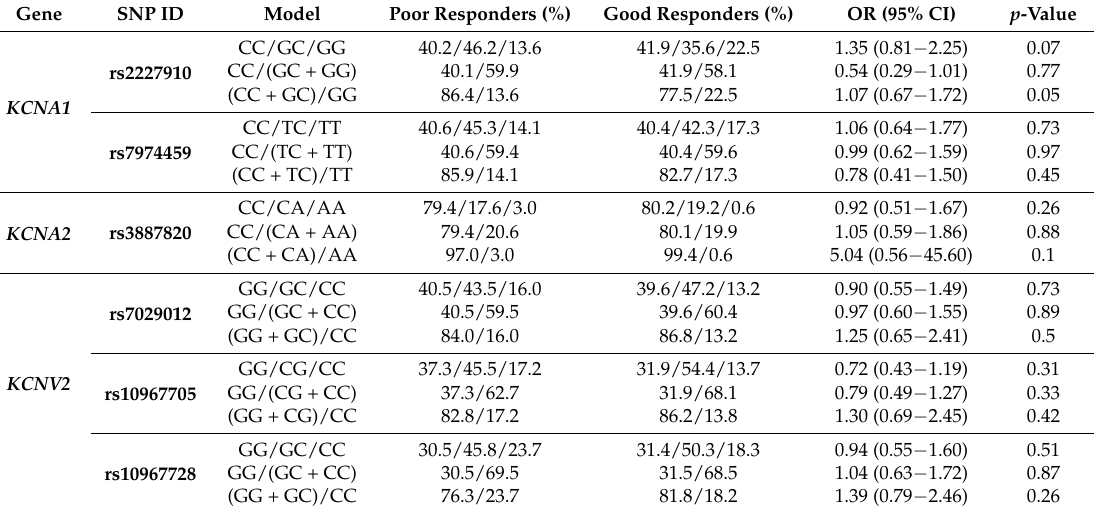
Table 5. Distribution of potassium channel related SNPs in the 134 poor responder and 162 good responder